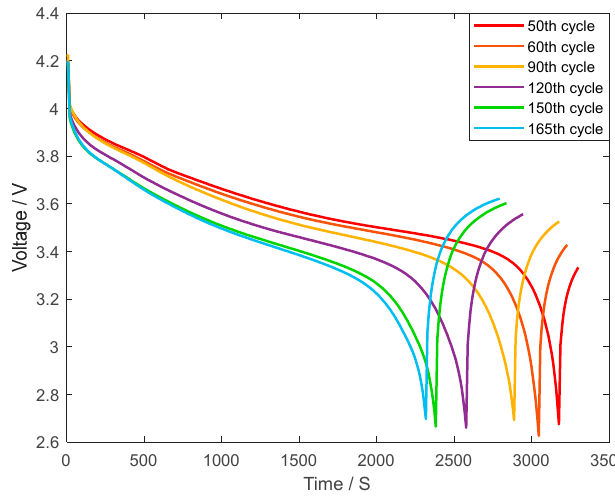
Figure 5. Charge voltage curve of B0005 battery under different cycles. The representative points have high visibility, such as the convex and convex of the curve, the highest and lowest points of the curve. According to the curve shape, there are six representative points of the curve in Figure 5, and the IDP algorithm extracts the six representative points of the curve. The results are shown in Figure 6.